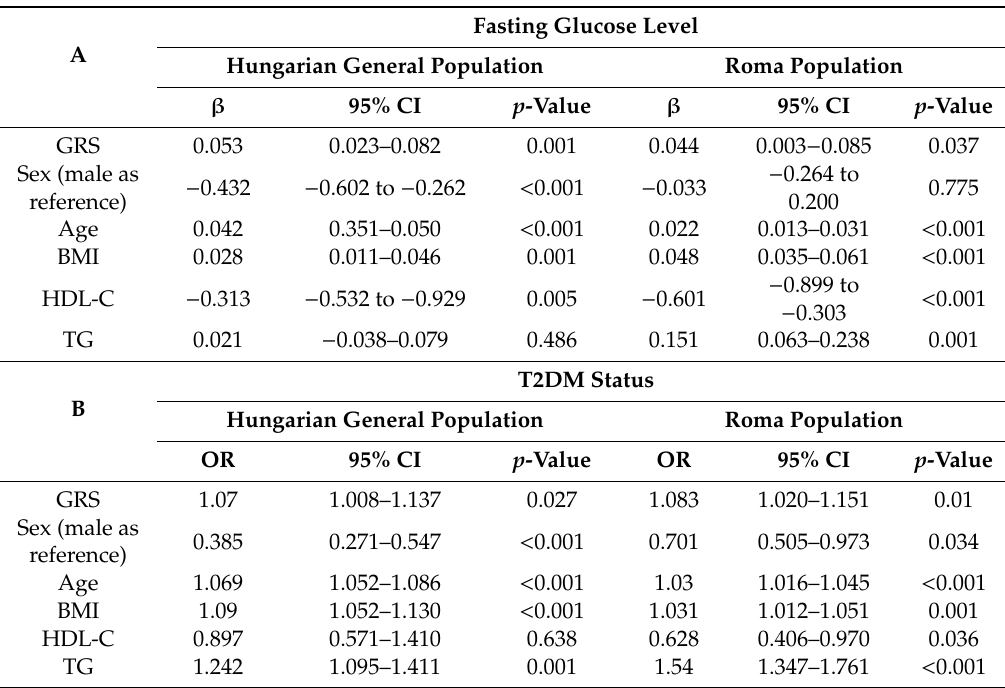
Table 5. Association of genetic risk scores (GRS) with fasting glucose level ( A ) and T2DM status ( B ) by study groups. The association was evaluated under adjusted regression models (sex, age, BMI, HDL-C, and TG level). OR, odds ratio; CI, confidence interval.